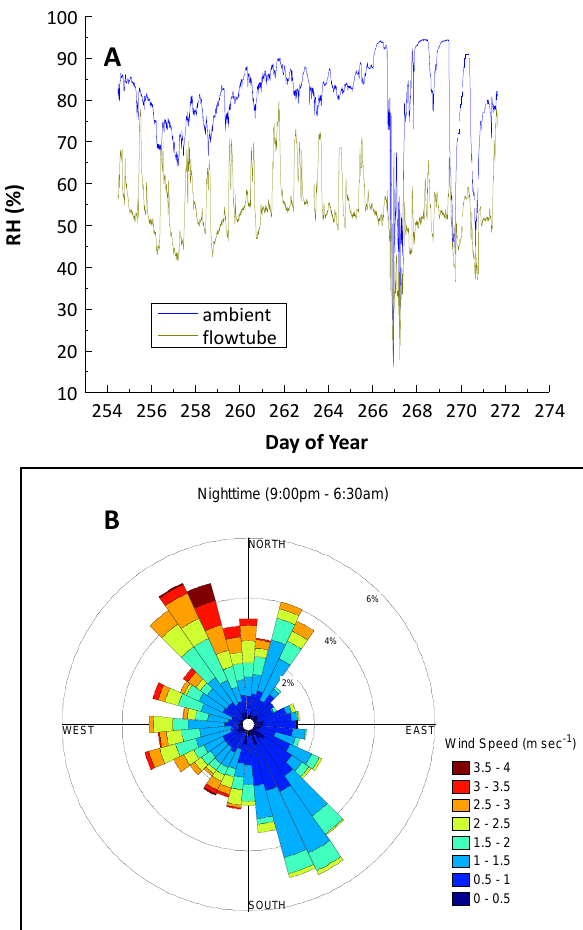
Fig. 1. Meteorological conditions during the measurement cam- paign. (A) The ambient relative humidity (RH%) is shown in blue. The calculated flow reactor RH is shown in olive. The large swings in flowtube RH accompany rapid temperature swings in the instru- ment trailer during the daytime. (B) A wind rose illustrating the nighttime wind conditions at the measurement